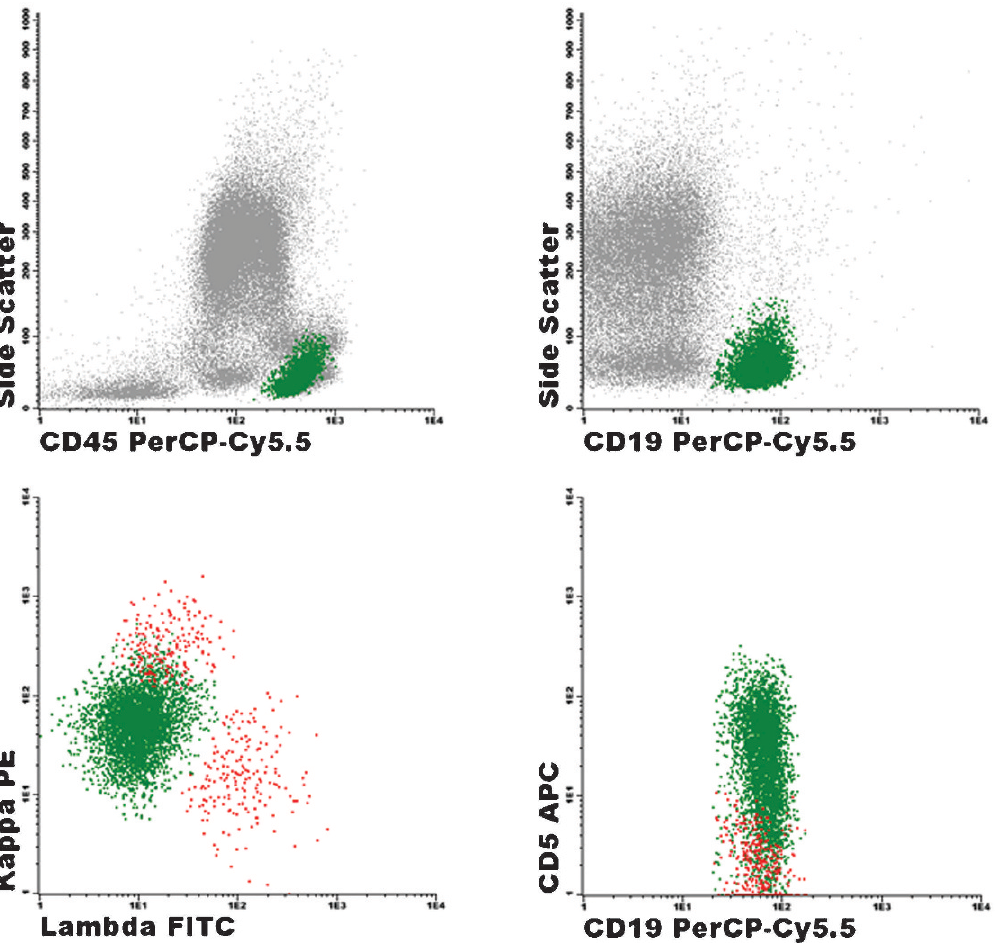
Figure 2 - Immunophenotypic analysis of bone marrow B-cells : monoclonal B-lymphocytes (green) are CD19 + , CD5 + , CD45 ++ and presents dim k light chain restriction. Residual polyclonal B-lymphocytes are illustrated in red. The same immunophenotypic B-cells were detected in the